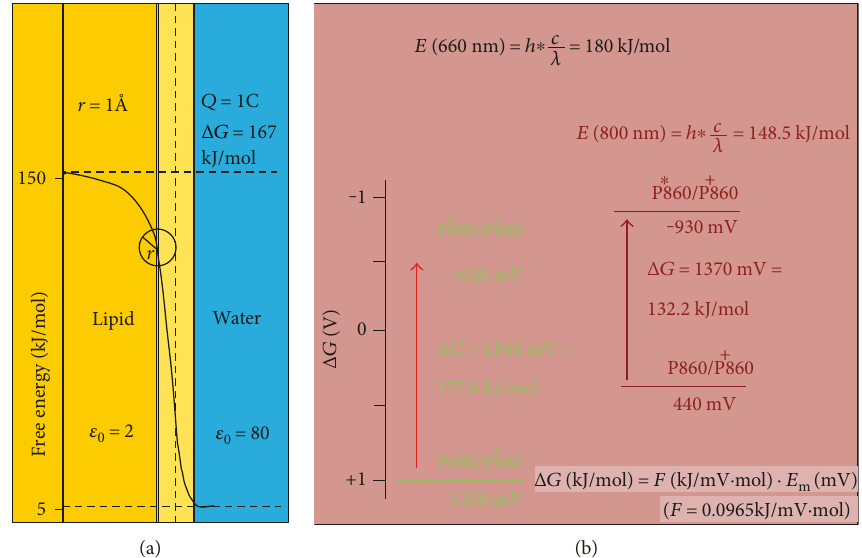
Figure 3: Comparison of the Coulomb free energy for transition of single charge from water to lipid phase of the membrane (a) with the redox free energy of transition from ground state to excited state primary donors of photosystem II (P For comparison, the free energy of 1 mole photon with the wavelength of 660 nm and 800 nm (wavelengths that are characteristic to chlorophyll and bacteriochlorophyll absorption, resp.) is also indicated. See explanation in the text.